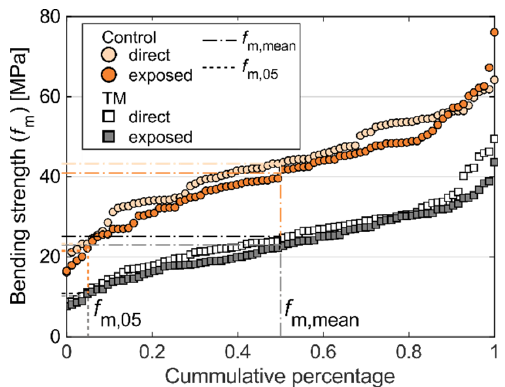
Figure 9. Bending strength of control (circles) and TM (squares) boards tested directly and after weathering. Mean ( f m,mean ) (dash-dotted line) and 5-percentile ( f m,05 ) (dashed line) values of bending strength are given for each sample set.